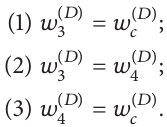
by the arrows. The sectional drawings of them are shown in Figure 7 and they correspond to the following three